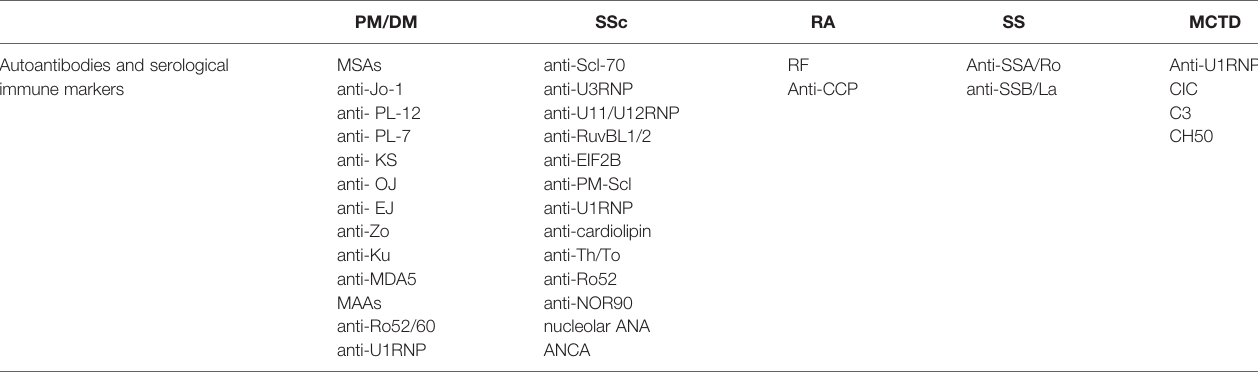
TABLE 4 | Autoantibodies and serological immune markers associated with